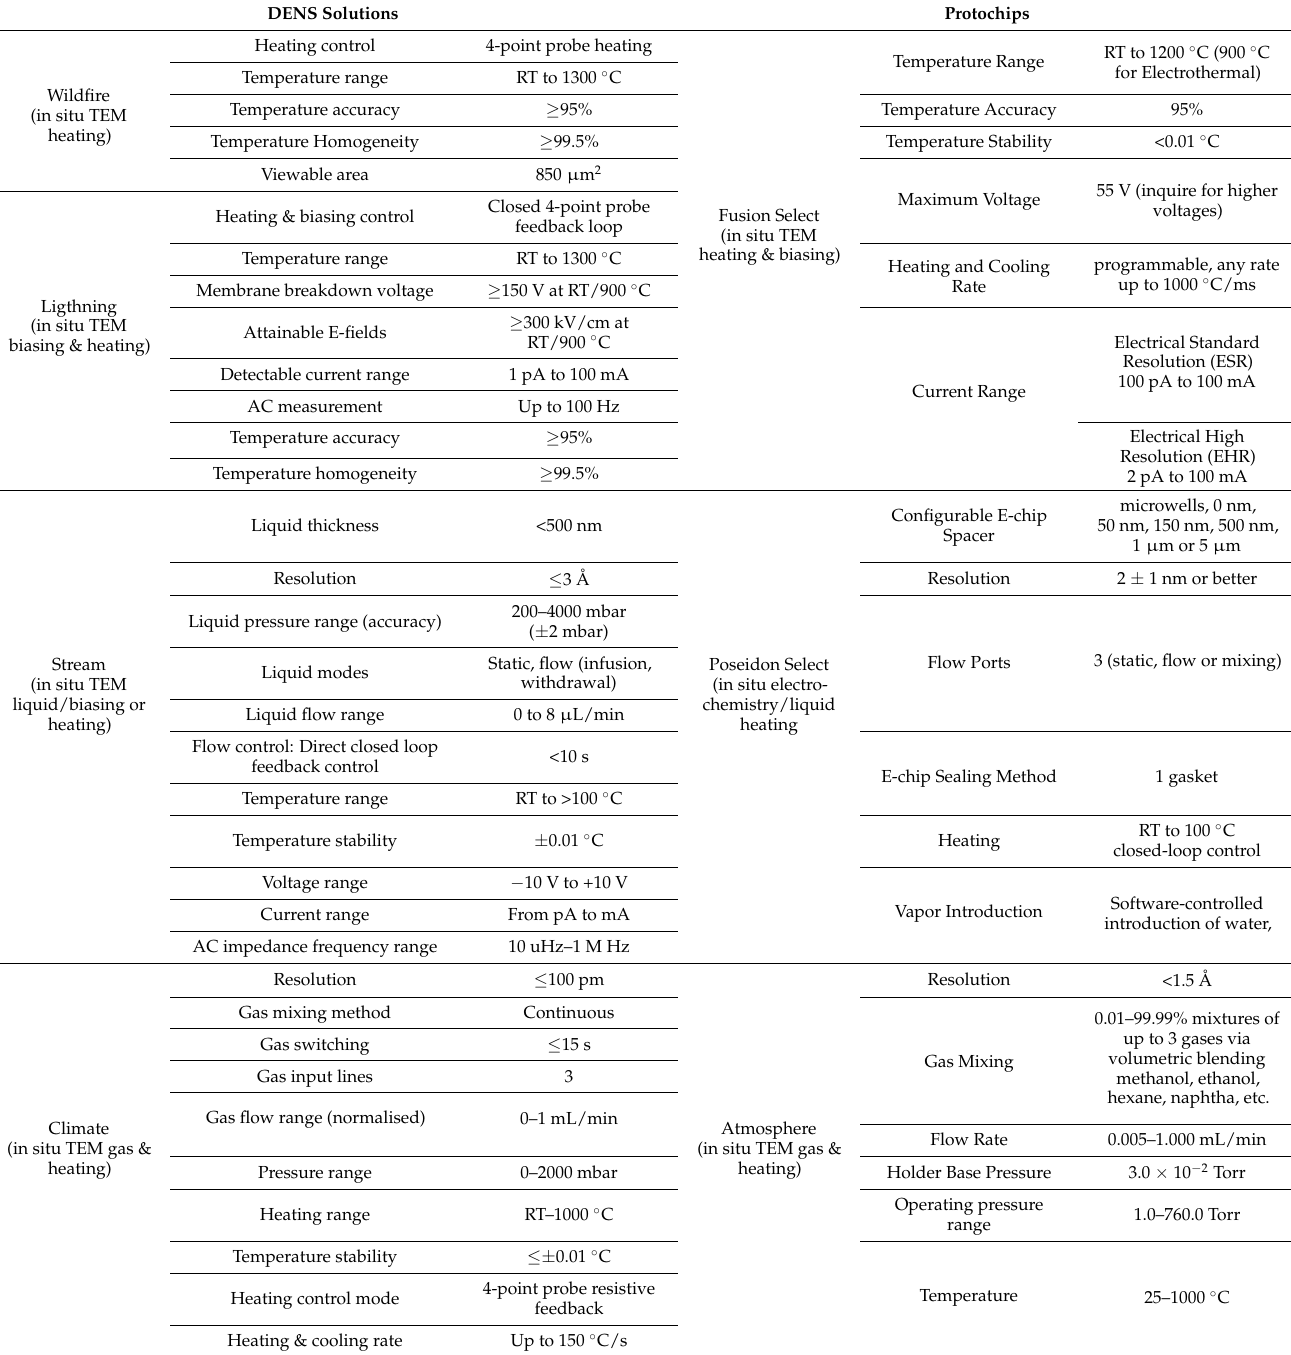
Table 2. Comparison of in situ TEM solutions from DESsolutions and